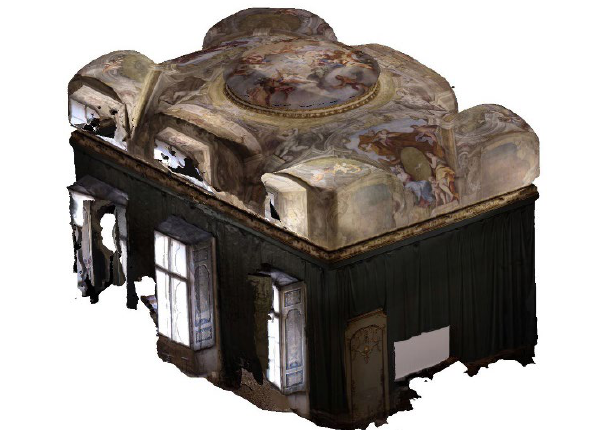
Figure 9. Sparse point cloud with aligned cameras from PhotoScan - ‘Camera grande del letto’ (Modelling: F. Natta)